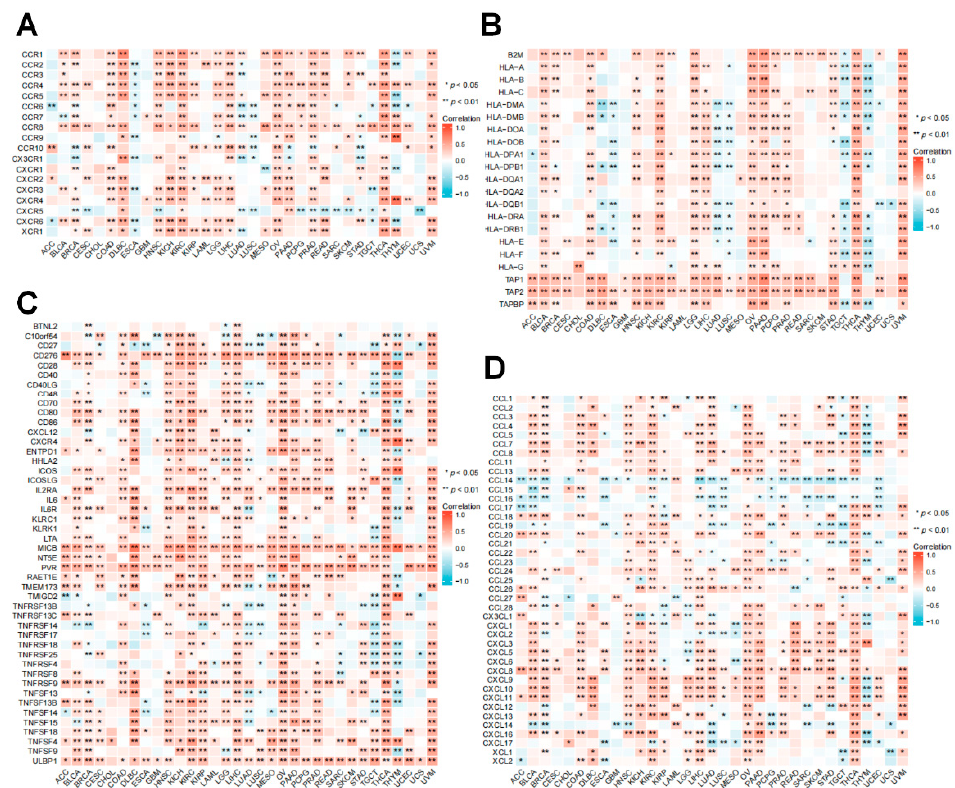
Figure 9. Correlation between RRM2 and immune-related genes. ( A – D ) Correlation between RRM2 and chemokine receptors ( A ), MHC genes ( B ), immune activated genes ( C ) and chemokines ( D ). (* p < 0.05, ** p < 0.01).